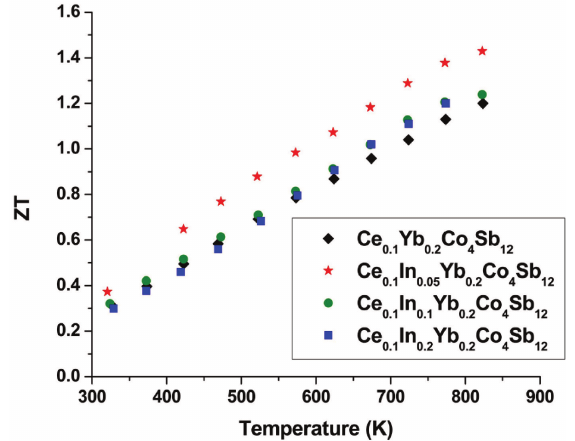
Figure 9. Temperature dependent ZT of the Ce 0.1 In y Yb 0.2 Co 4 Sb 12 skutterudites with an overall 15% improvement in ZT for sample Ce 0.1 In 0.05 Yb 0.2 Co 4 Sb 12 resulting in a ZT >